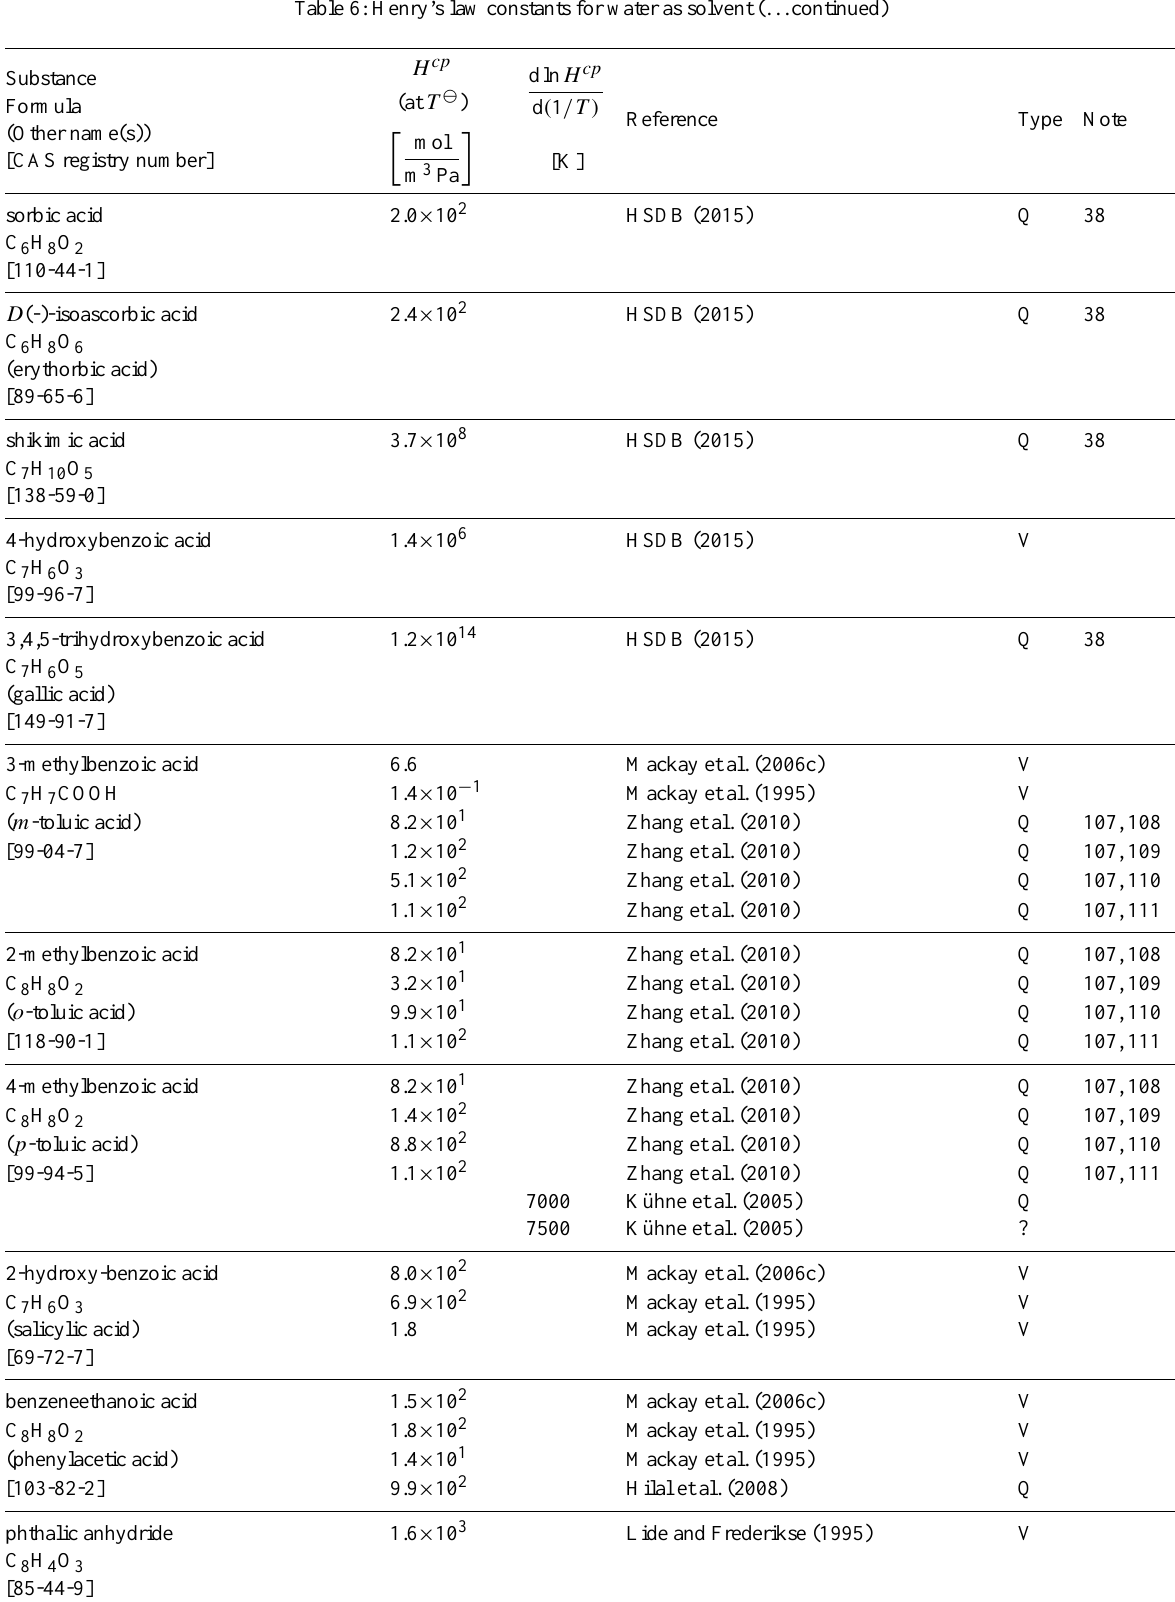
Table 6: Henry’s law constants for water as solvent